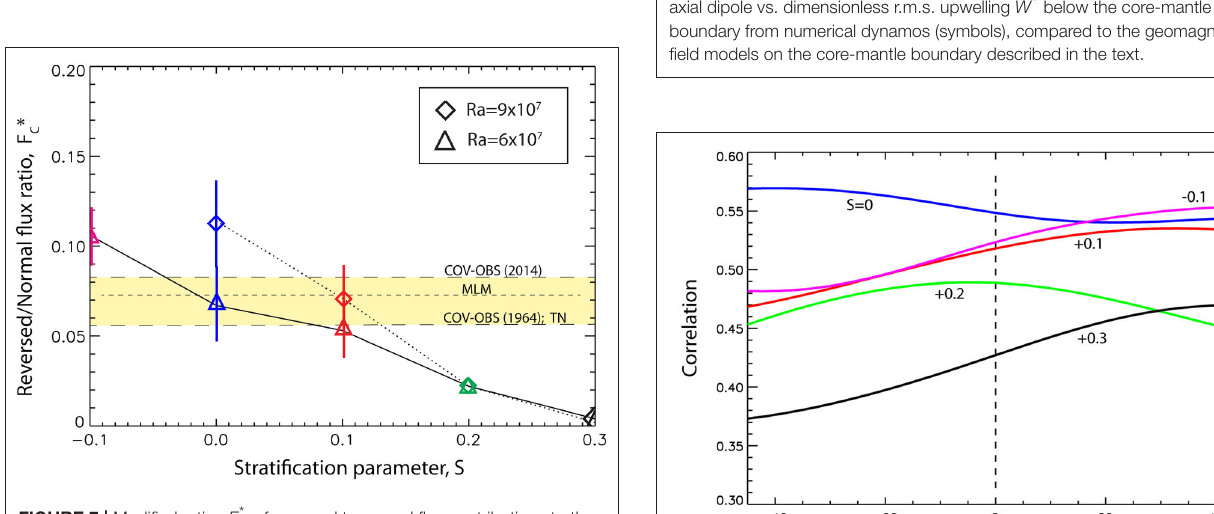
FIGURE 7 | Modified ratios F * C of reversed to normal flux contributions to the axial dipole vs. stratification parameter S from numerical dynamos (symbols), compared to F * C from geomagnetic field models on the core-mantle boundary. Geomagnetic field F * C values labeled COV-OBS, MLM, and TN are explained in the text. Symbol error bars denote one standard deviation of dynamo snapshots.